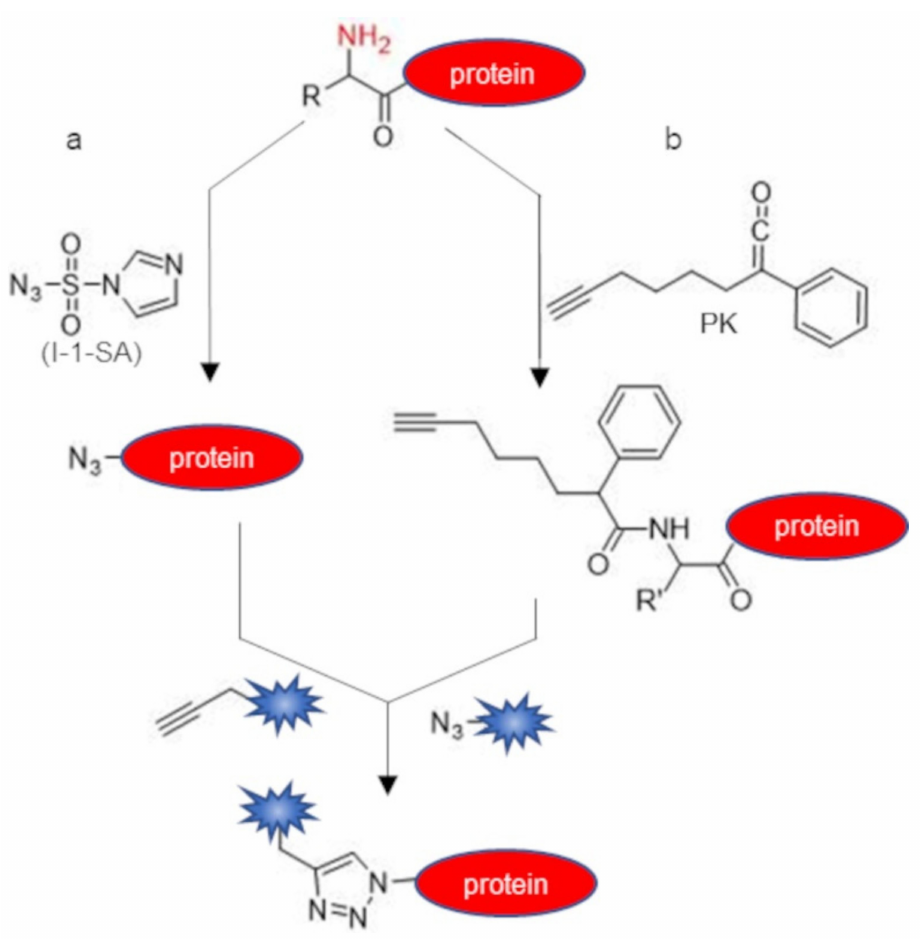
Figure 5. Two-step N-terminal protein labeling. ( a ) N-terminal alpha-amine group can be converted into an azide group by diazotransfer with imidazole-1-sulfonyl azide (I-1-SA); ( b ) acylation with phenyl ketene (PK) allows for the introduction of a N-terminal alkyne group. After the selective introduction of an alkyne or an azide function at the protein N-terminus, the protein can be further modified through copper-catalyzed [3 + 2] cycloaddition (CuAAC) click